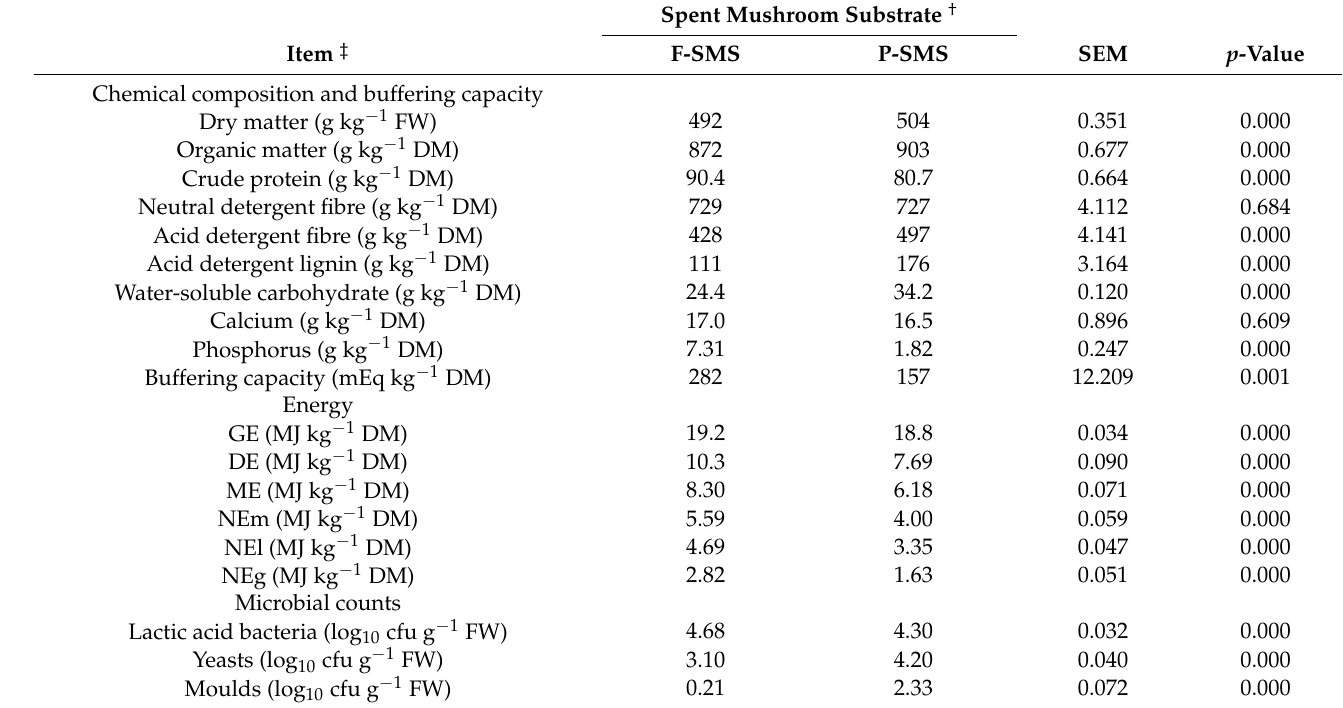
Table 2. Characteristics of spent mushroom